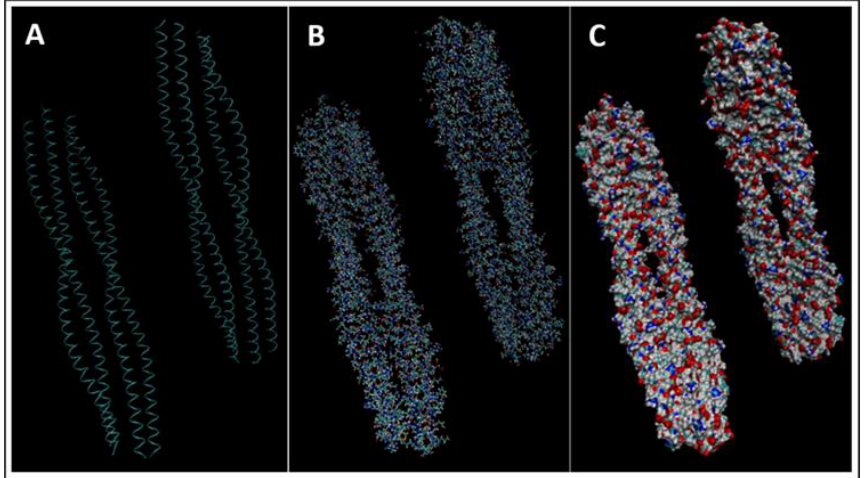
Figure 19. ( A ) A cartoon model, ( B ) a bonds model, and ( C ) a surface model of GFAP.